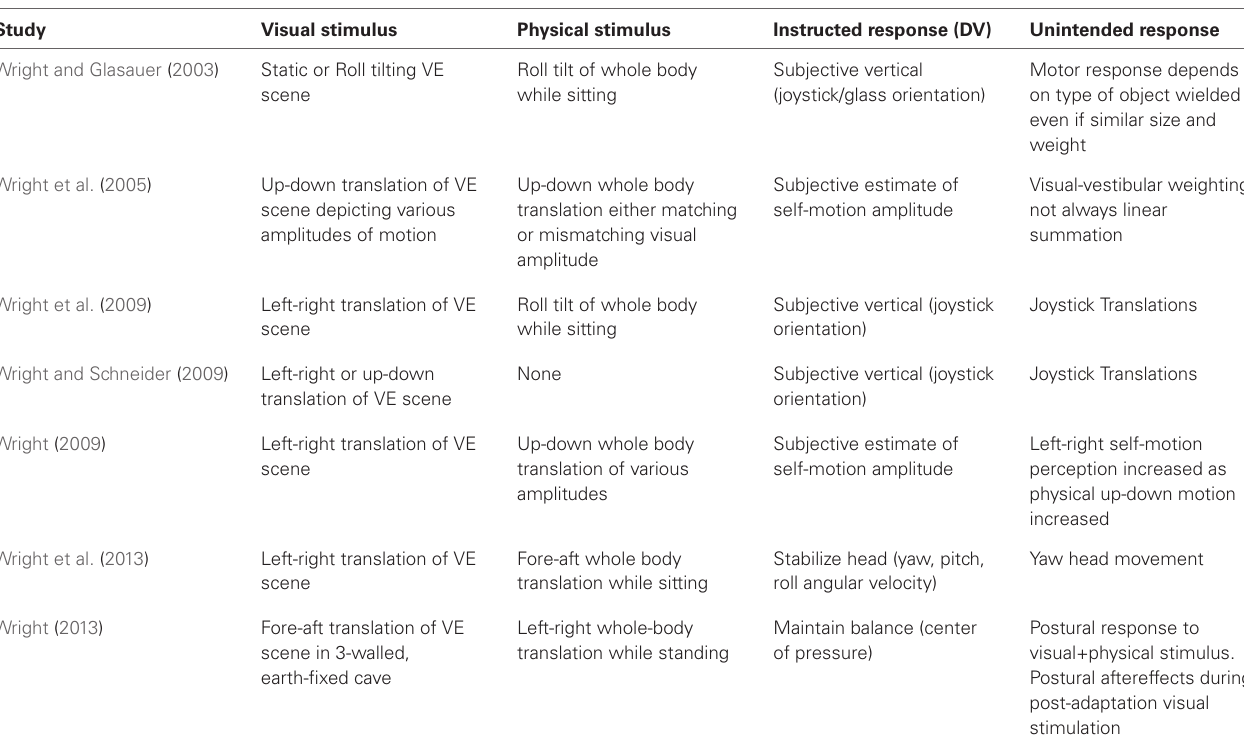
Table 1 | Perceptual and/or motor behavior in immersive VE